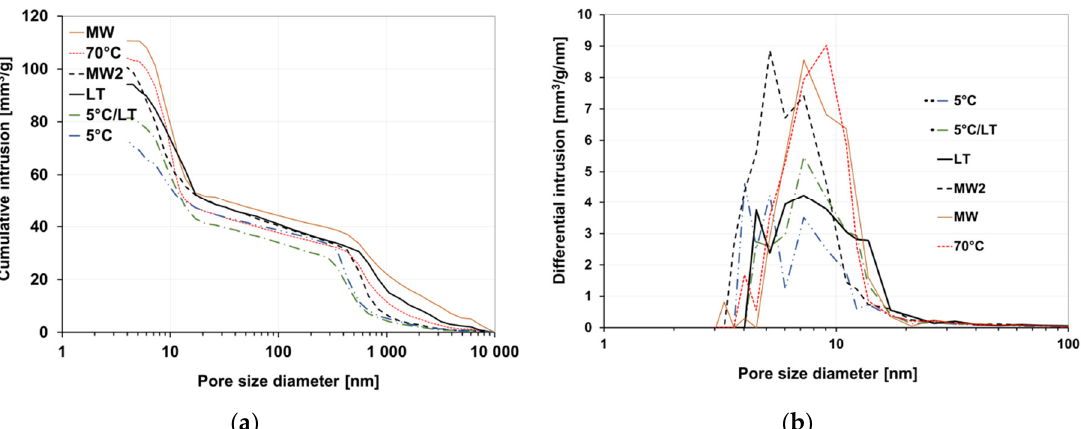
Figure 7. Cumulative ( a ) and differential ( b ) pore volumes for geopolymers made from water glass with density 1.5 g · cm − 3 cured at the various